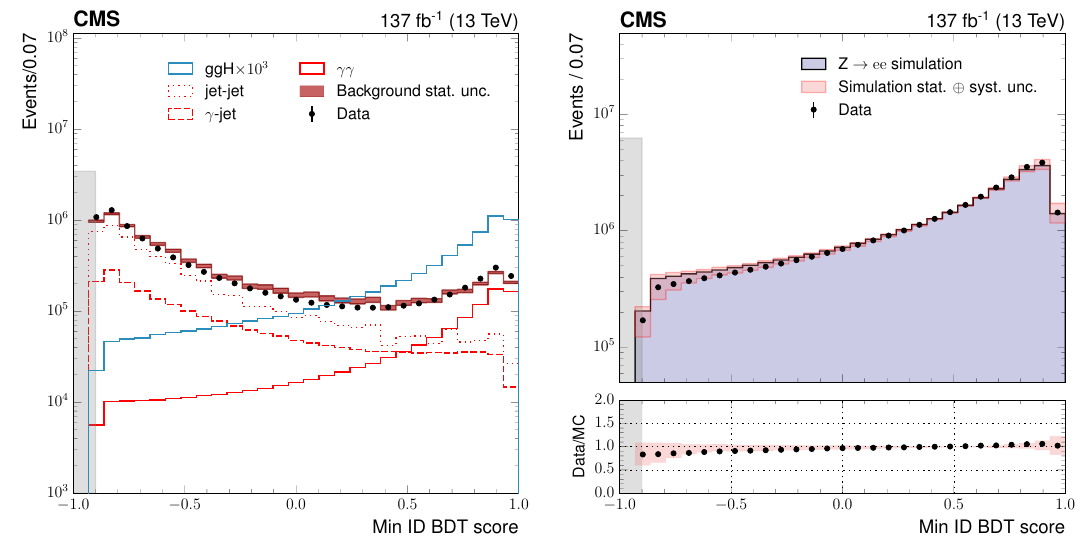
Figure 3 . The left plot shows the distribution of the photon identification BDT score of the lowest scoring photon in diphoton pairs with 100 < m < 180 GeV, for data events passing the gg preselection (black points), and for simulated background events (red band). Histograms are also shown for different components of the simulated background. The blue histogram corresponds to simulated Higgs boson signal events. The right plot shows the same distribution for Z → ee events in data and simulation, where the electrons are reconstructed as photons. The statistical and systematic uncertainty in simulation is also shown (pink band). Photons with an identification BDT score in the grey shaded region (below − 0 . 9 ) are not considered in the analysis. The full data set collected in 2016–2018 and the corresponding simulation are